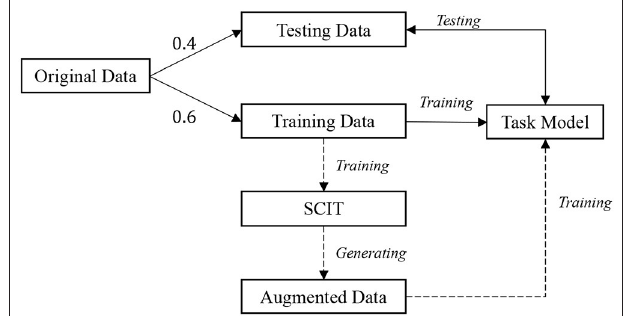
FIGURE 4 | Data utilization process. The originally collected data are split into testing and training data, 0.4 and 0.6, respectively. The training data is firstly adopted to train our SCIT model that then generates the augmented data. Next, the training data along with the augmented data are leveraged to train the task model (image classification, object detection, or instance segmentation). The dotted lines suggest the data augmentation process. The SCIT model is one of our main contributions, which introduces new variations for the original data and, thus, encourages the task model to have